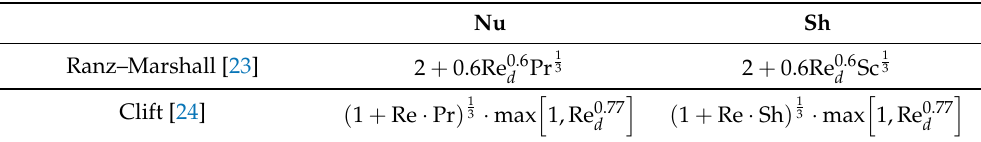
Table 1. Correlations for Nusselt and Sherwood